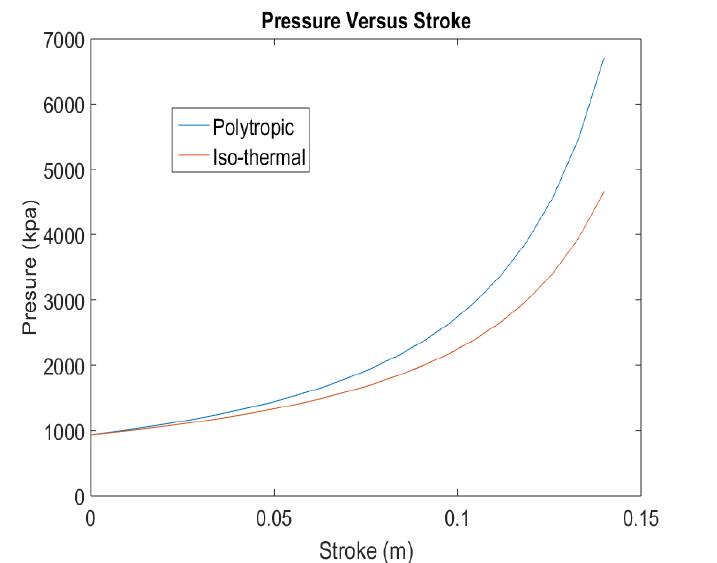
Figure 10. Iso-thermal and Polytropic behavior of Oleo Pneumatic Strut.